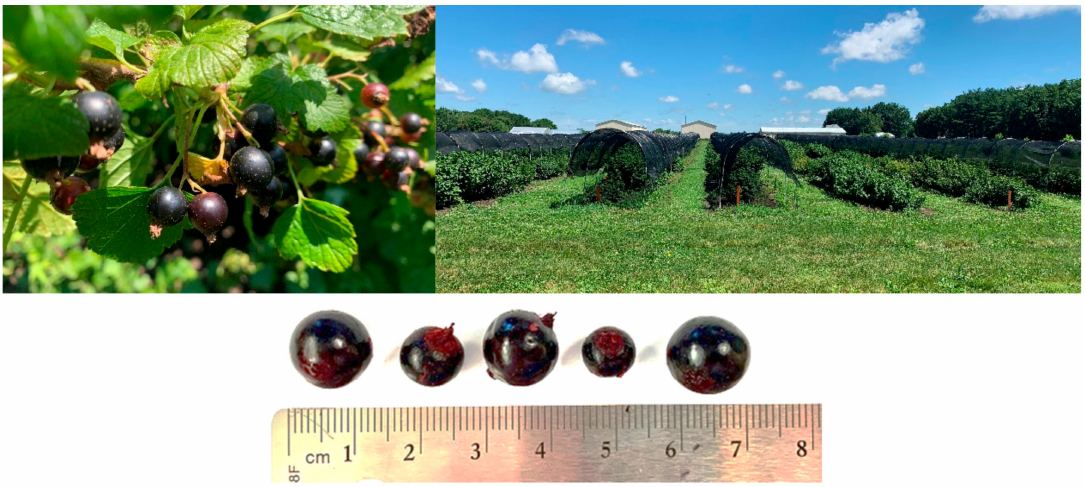
Figure 1. Blackcurrants grown in Urbana, Illinois by the Department of Crop Sciences, University of